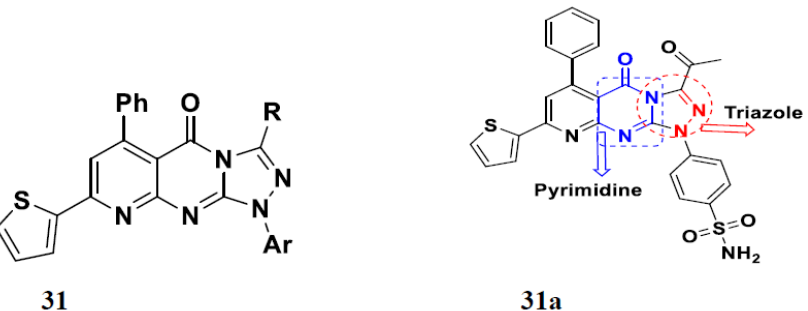
Figure 34. Structure of a pyrimidine-triazole based hybrids and the most promising compound 31a . Table 24. In vitro cytotoxic activities of pyrimidine-triazole hybrid compounds 31 ( b – e ).